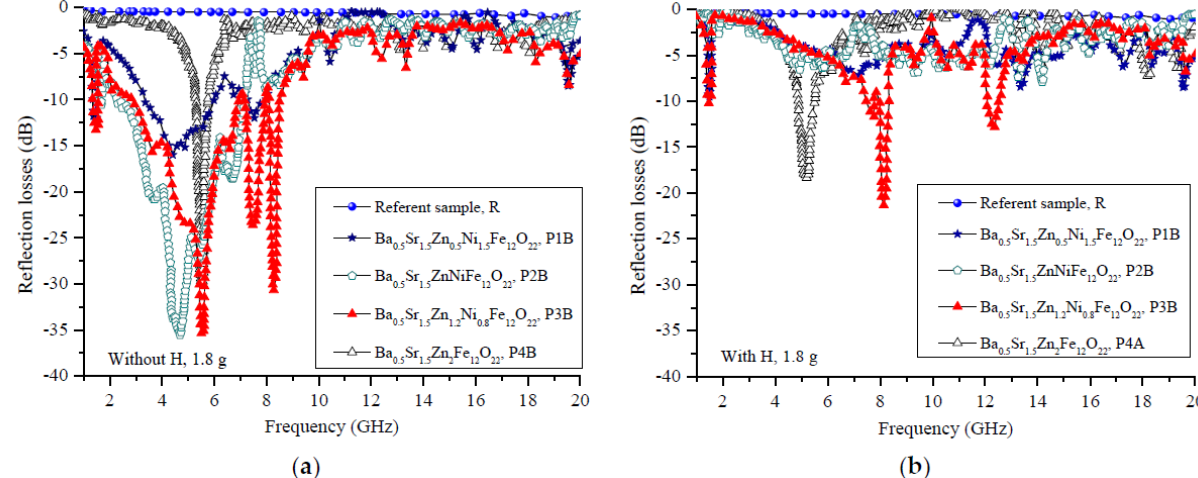
Figure 5. Reflection losses of the B series of samples with a filler ratio of 1.8 g per 1 cm 3 ( a ) with a magnetic field and ( b ) without an external magnetic field applied.